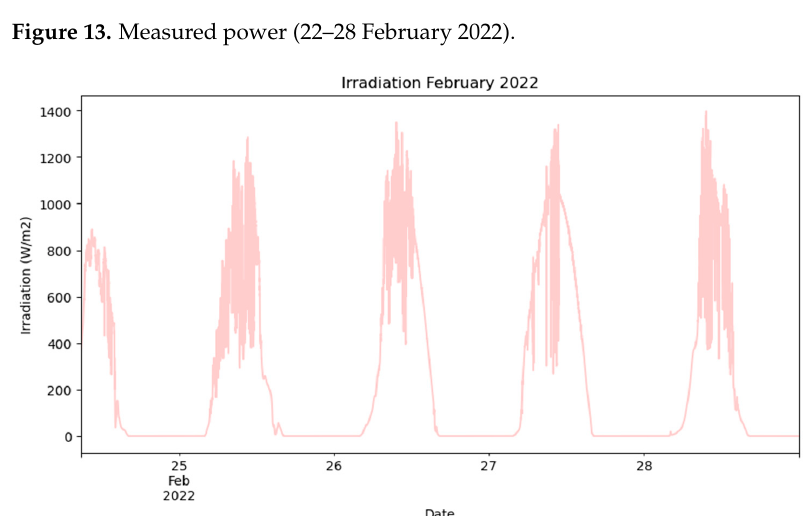
Figure 14. Measured irradiance (22–28 February 2022). Figure 15 compares the average hourly power consumed and minimum irradiance measured at the Bunjako microgrid (0°0 ′ 10 ″ N, 32°8 ′ 4 ″ E). As is typical, average irradiation peaks around 11 am and after that declines, and the power consumption displays an in- creasing trend during the hours of waning and no irradiance [52]. The solar power output generated, as shown in Figure 16, was estimated using the following global formula [53].